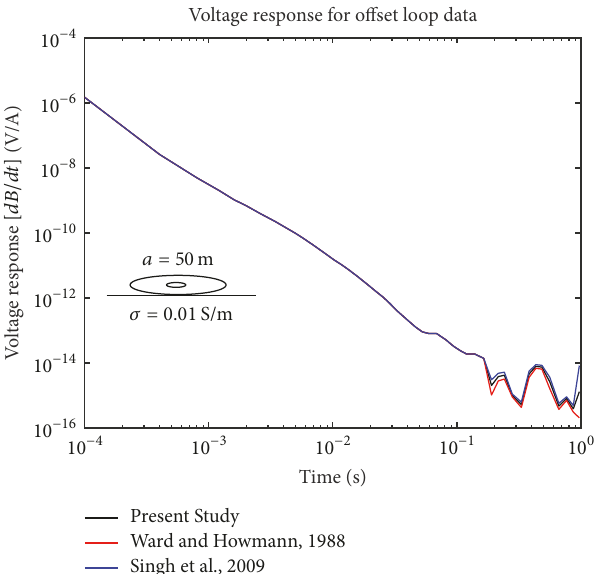
Figure 2: Comparison of results computed using the present method for voltage response of vertical magnetic field at the center of a large circular loop source of radius, 𝑎 = 50 m, placed over the surface of a homogeneous earth model of conductivity ( 𝜎 = 0.01 S/m) with the results generated using the analytical expression given by ward and Hohmann (1988) and Singh et al.